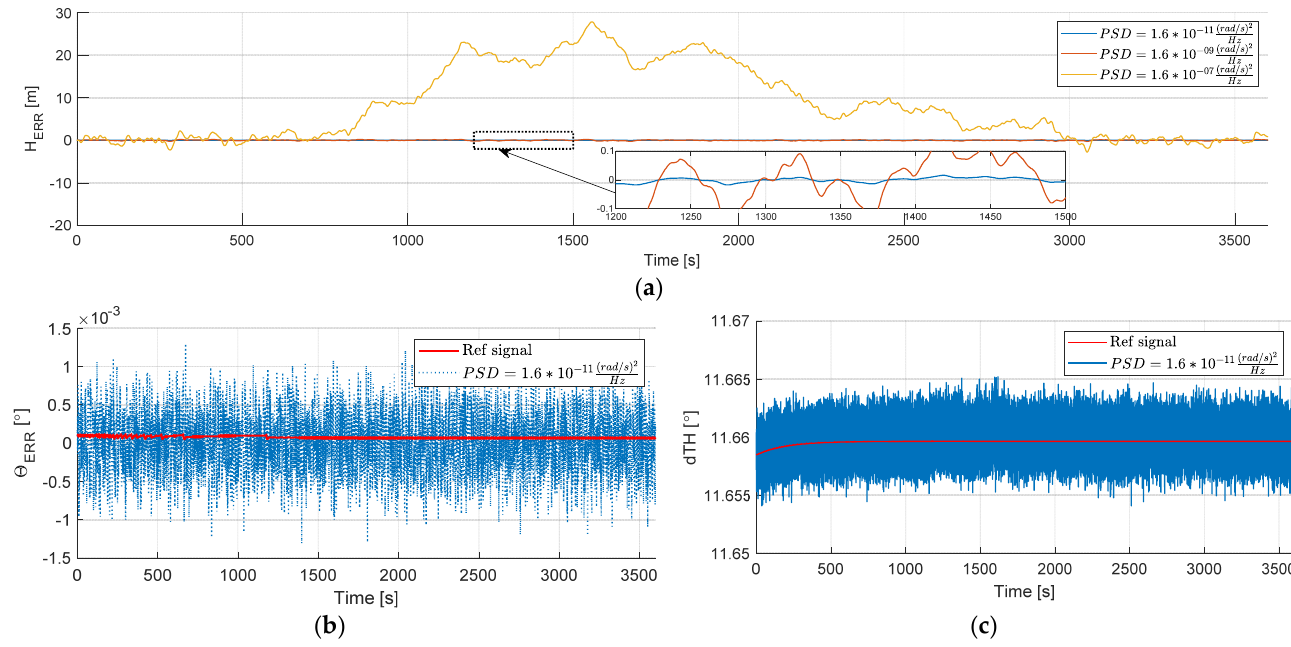
Figure 7. Influence of white noise on a stable flight: ( a ) Comparison of altitude error; ( b ) Comparison of pitch angle error; ( c ) Comparison of elevator trimmer deflection.